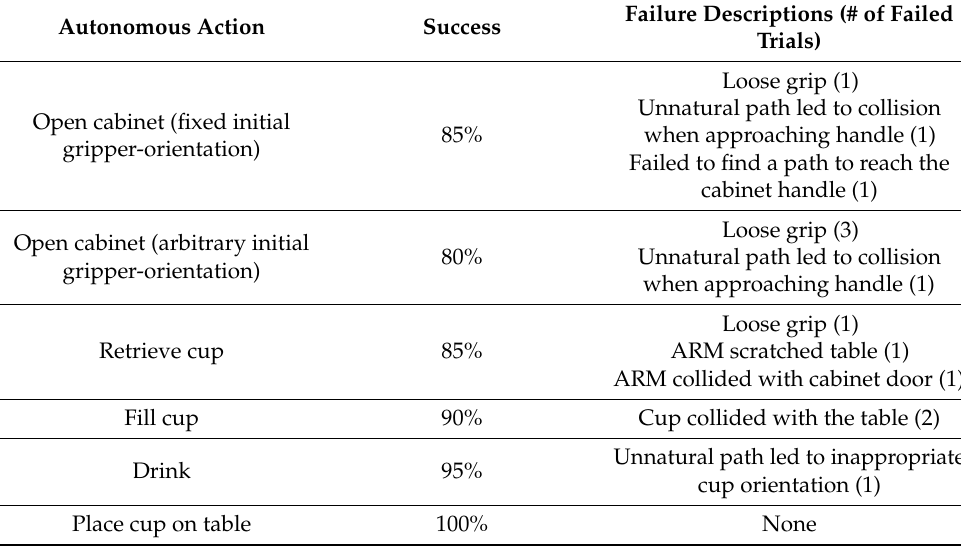
Table 2. Bench-top test results of autonomous actions under VGS control.